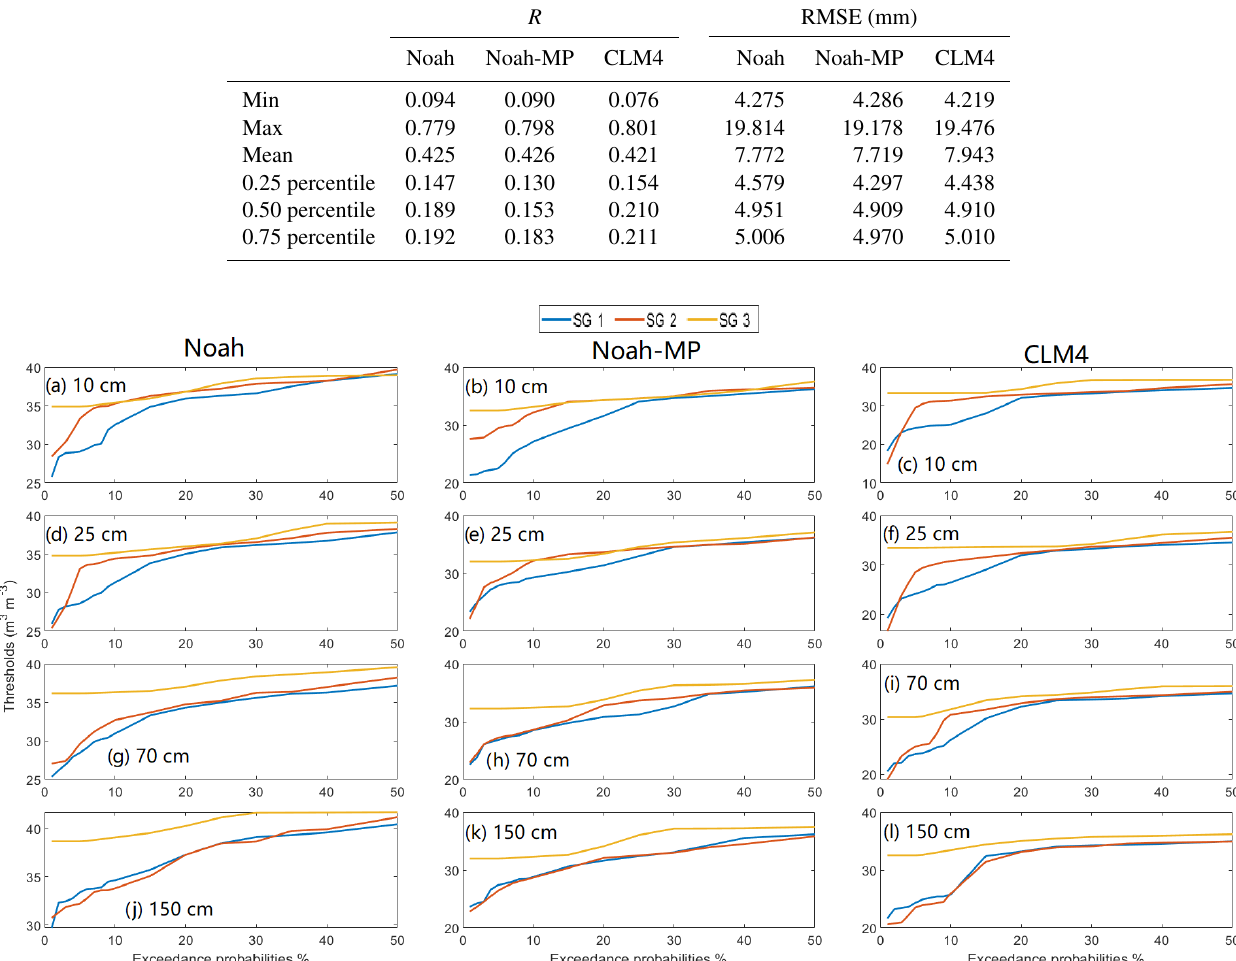
Table 4. Statistical summary of the WRF performance in simulating rainfall for the whole study region, based on comparison with the in situ rainfall network.